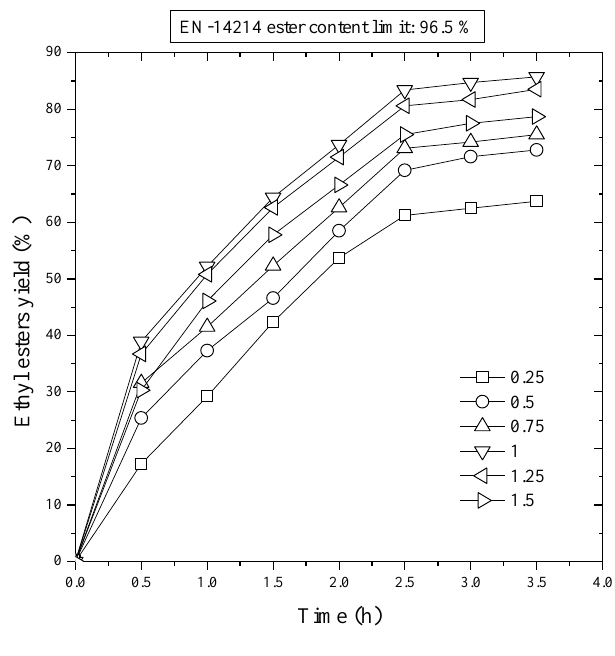
Figure 1. First stage transesterification. Effect of the mass ratio of NaOH to oil on ethyl ester yield. Ethanol/oil molar ratio, 12:1; reaction temperature, 80